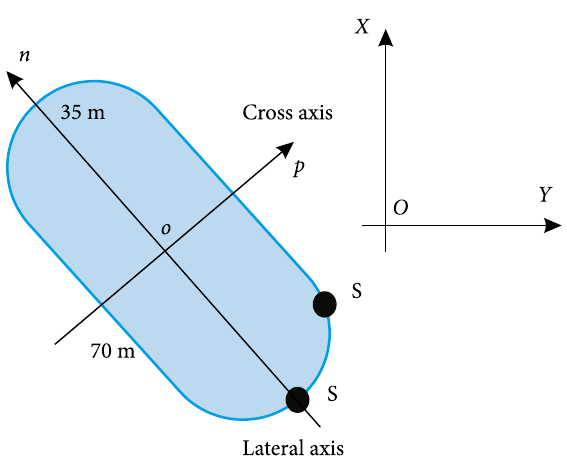
Fig. 3. The geometry of the building and its position relative to the coordinate system accepted